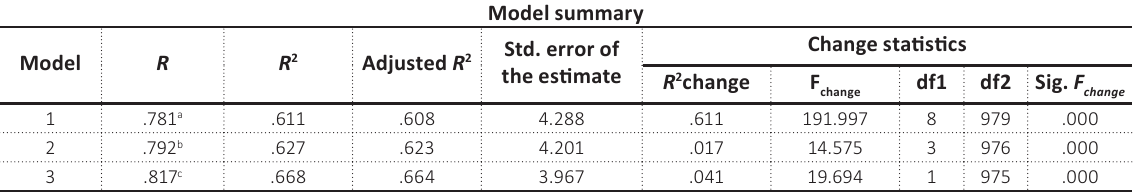
Source: Field survey results (2019).